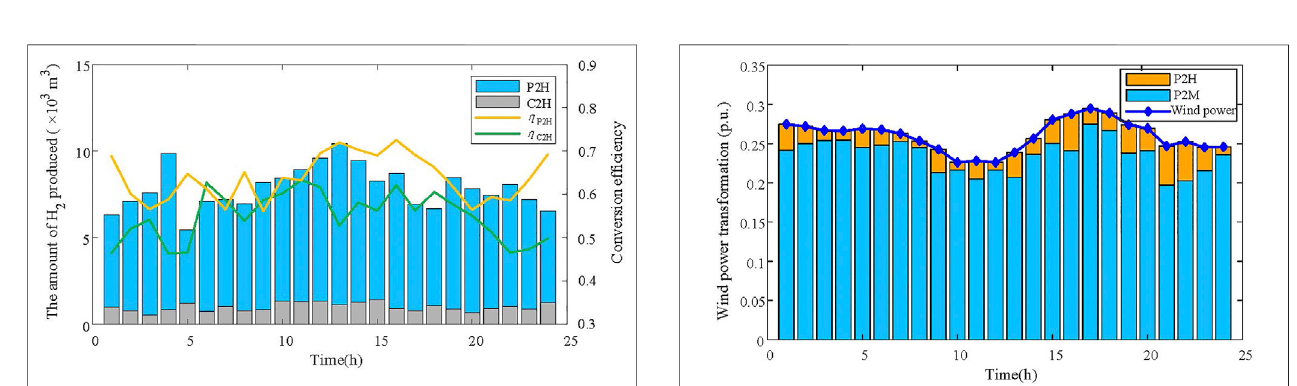
FIGURE 5 | The energy conversion Sankey diagram of the proposed IEGS.